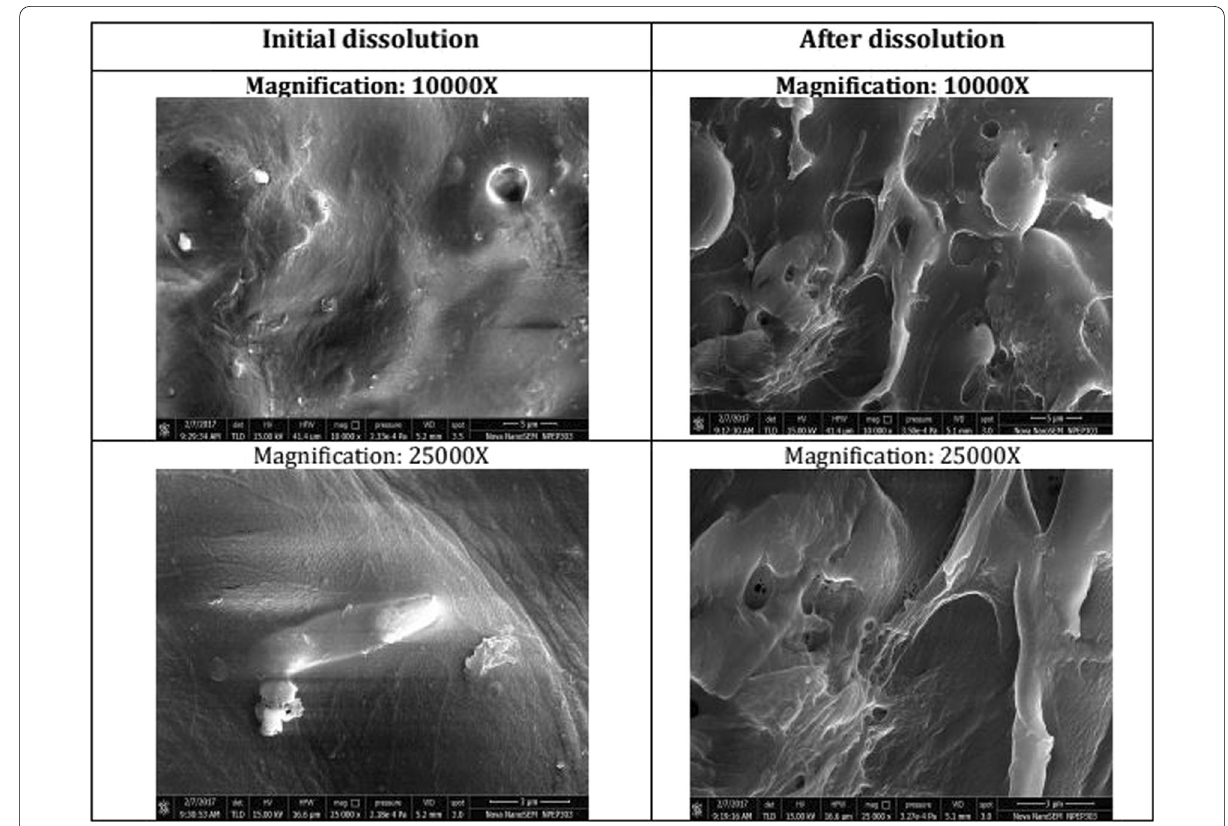
Fig. 6 Coating membrane morphology of initial and after dissolution samples by